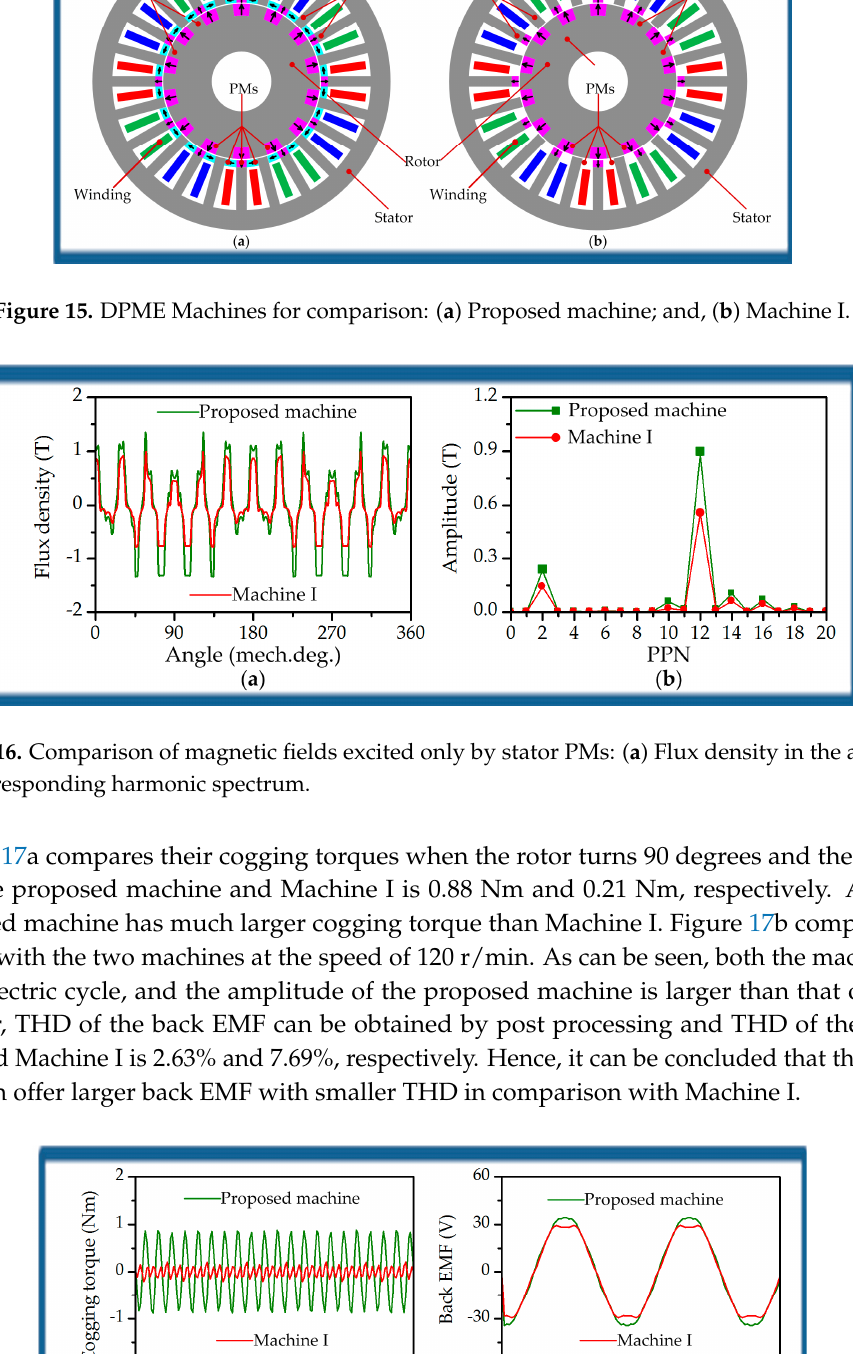
Figure 15. DPME Machines for comparison: ( a ) Proposed machine; and, ( b ) Machine I.